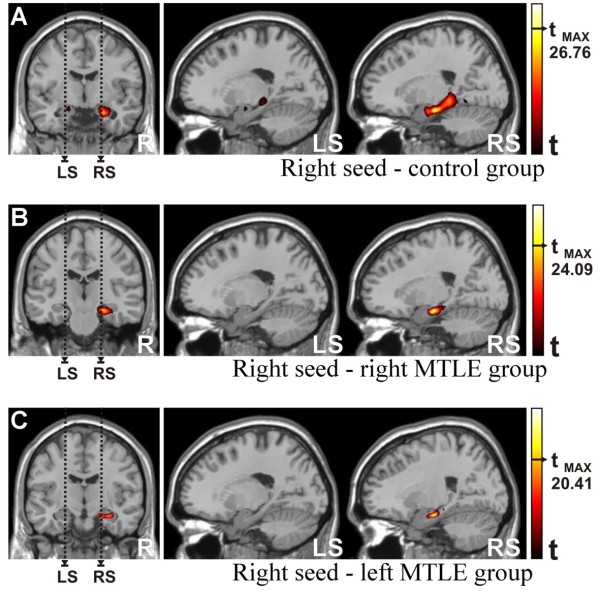
Functional Connectivity Maps (intragroup comparisons). Right seed: a) Control group: Major cluster parameters (RS): Tmax = 26.76 at (28,-17,-20) MNI coord. and 6087 voxels. Minor cluster parameters (LS): Tmax = 23.79 at (-28,-19,-34) MNI coord. and 2466 voxels. b) Right MTLE patient group. Major cluster parameters (RS): Tmax = 24.09 at (20,-15,-22) MNI coord. and 1664 voxels. c) Left MTLE patient group. Major cluster parameters (RS): Tmax = 20.41 at (28,-16,-23) MNI coord. and 1179 voxels. Abbreviations - LS: left sagittal image, RS: right sagittal image. Statistical maps with t-scores higher than 15.